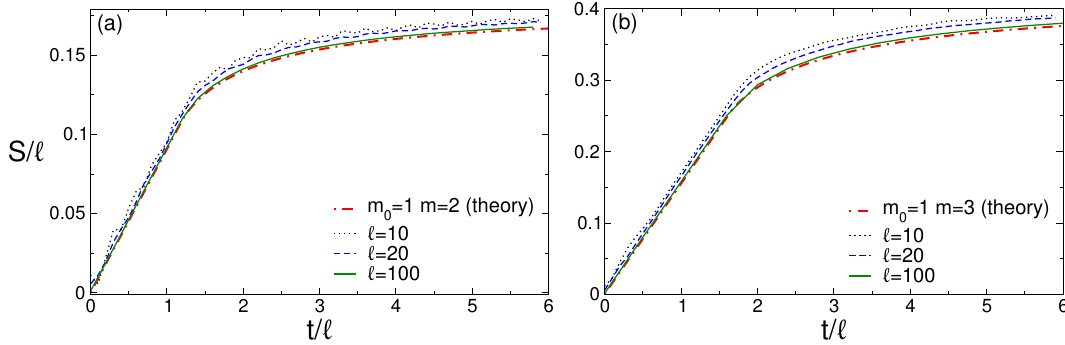
Figure 1: Entanglement dynamics after a mass quench in the harmonic chain: Theoretical pre- diction using the quasiparticle picture. The entropy density S /(cid:96) is plotted against the rescaled time t /(cid:96) , with (cid:96) the size of A . Different lines are results for quenches with different values of = 1 is the same for all the quenches. the chain mass m . The pre-quench value of the mass m 0